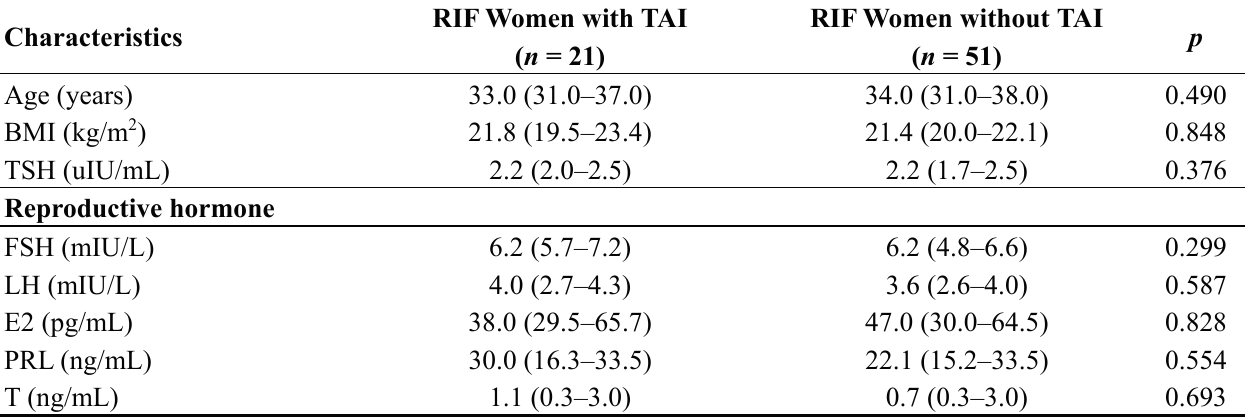
Table 1. Basic clinical characteristics of repeated implantation failure (RIF) women with or without thyroid autoimmunity